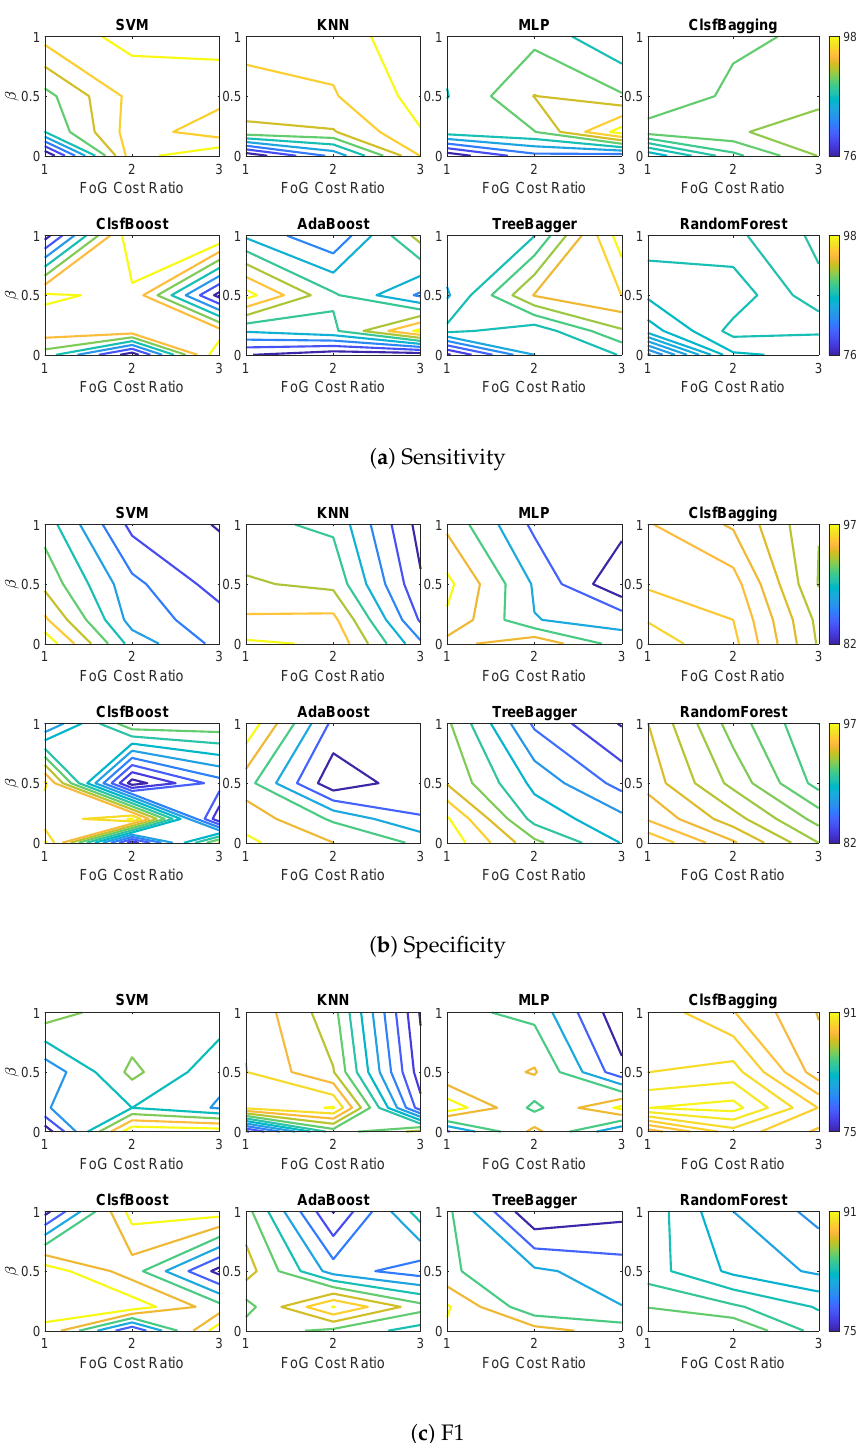
Figure 3. Performance measures of classifiers for patient-dependent models using synthetic data and cost of